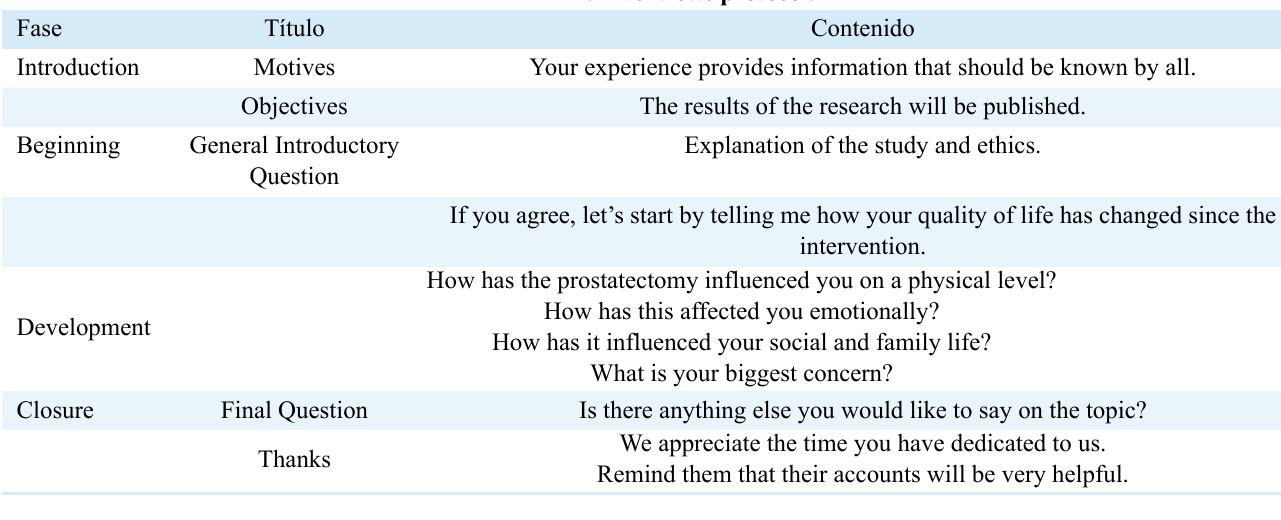
TABLE 2. Interviews